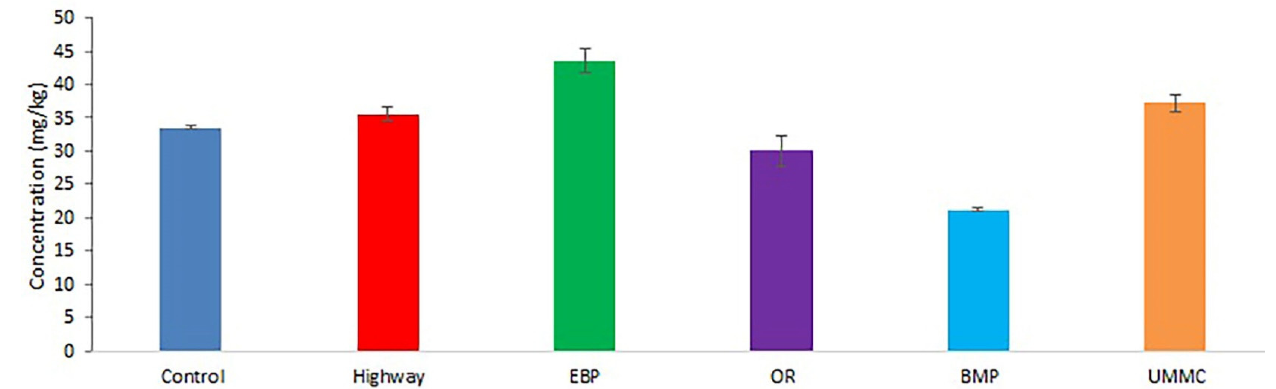
Figure 4. Zn concentration (mean ± 95% confidence interval) in coltsfoot from studied